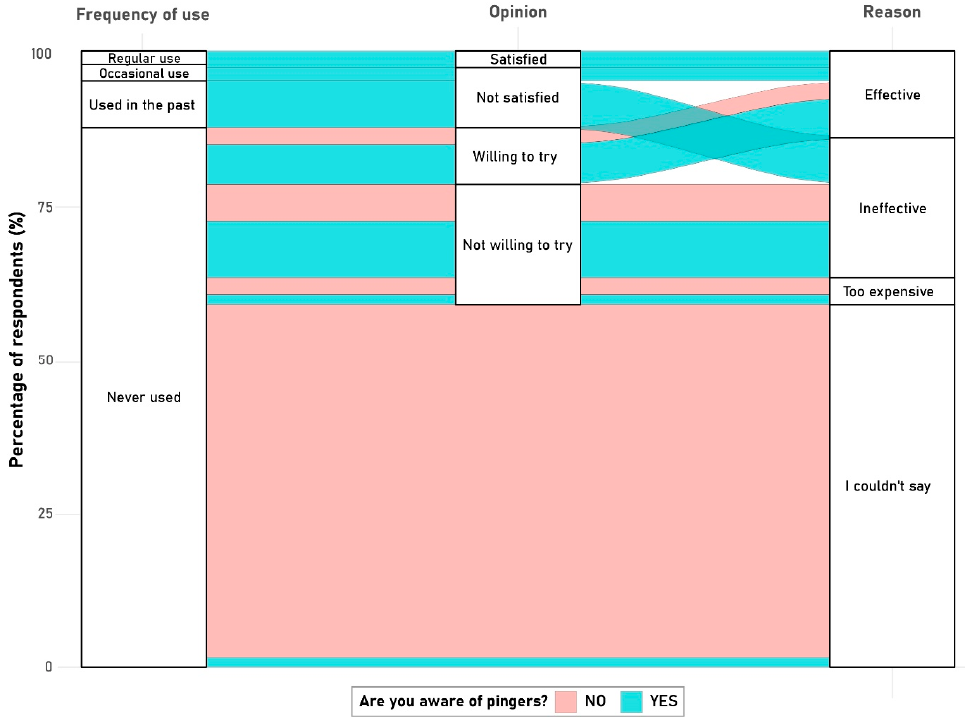
Figure 7. Alluvial plot representing the combinations of answers to the following questions: “Are you aware of pingers?”; “What is your experience with their use?”; “What is your opinion?”; “What is the reason for your opinion?”. The height of each flux represents the percentage of respondents to a certain